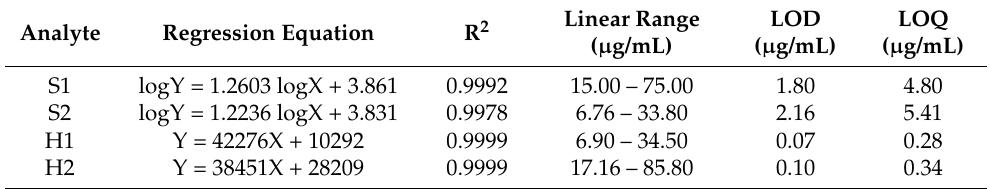
Table 1. Regression equation, correlation coefficient, linear ranges, LOQ, and LOD of four analytes. Analyte Regression Equation